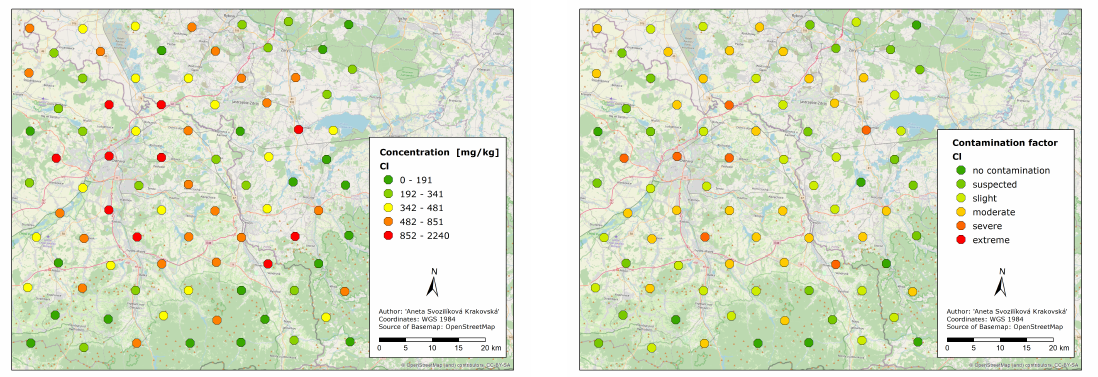
Figure 14. The distribution of concentrations of Cl and the values of the contamination factor for